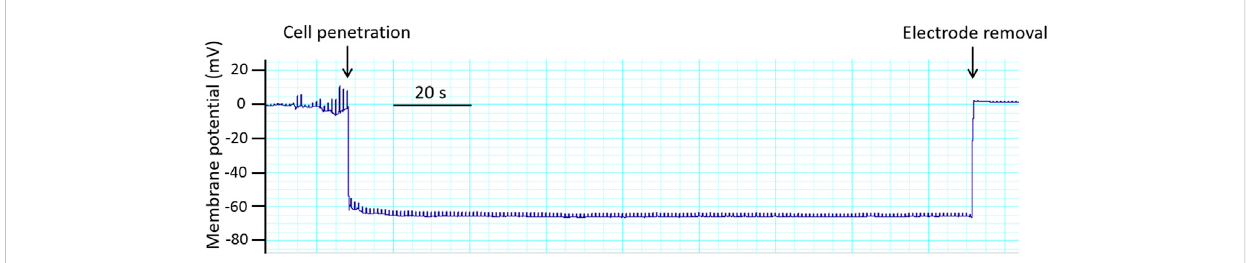
FIGURE 8 Originaltraceobtainedinanexperimentwithmembranepotentialregistrationinratsaphenousartery.Membranepotentialrecordingsareaccepted according to the following criteria: (i) a sharp drop of the potential on cell penetration; (ii) a stable level of the membrane potential recording for at least 30 s; (iii) a return to the zero-potential level after electrode removal; and (iv) a similar electrode resistance before and after the measurement (Nilsson et al., 1998; Rummery and Brock, 2011; Shvetsova et al.,